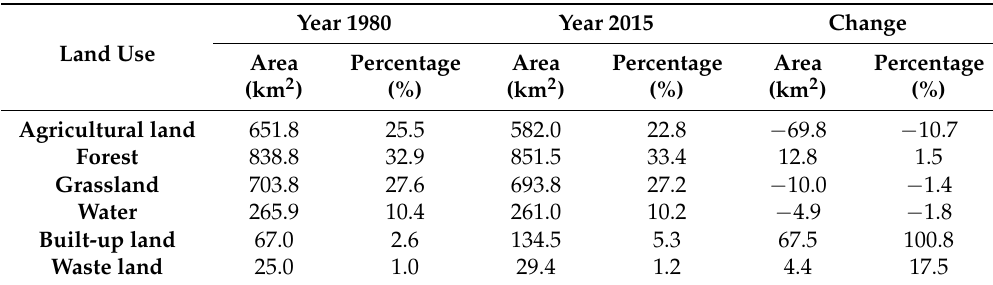
Table 2. Land use change from 1980 to